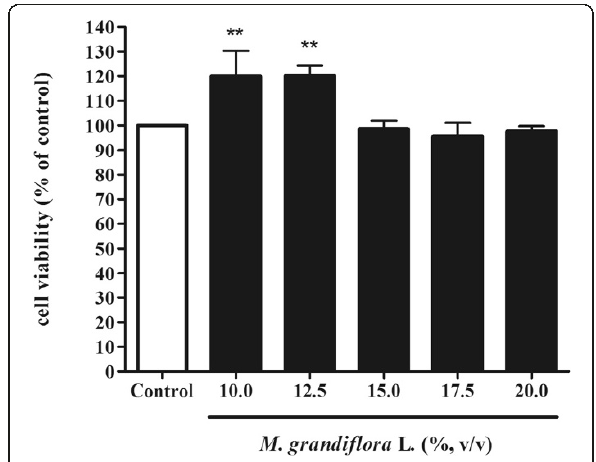
Figure 1 Effect of M. grandiflora L. flower extract on B16F10 cell viability. Cells were treated with various concentration of flower extract (10, 12.5, 15, 17.5, 20%; v/v) for 24 h and the cell viability was measured by MTT assay. Results are expressed as percentage of cell viability relative to control. Data are presented as mean±S.D. Values are significantly different by comparison with control. ** p <